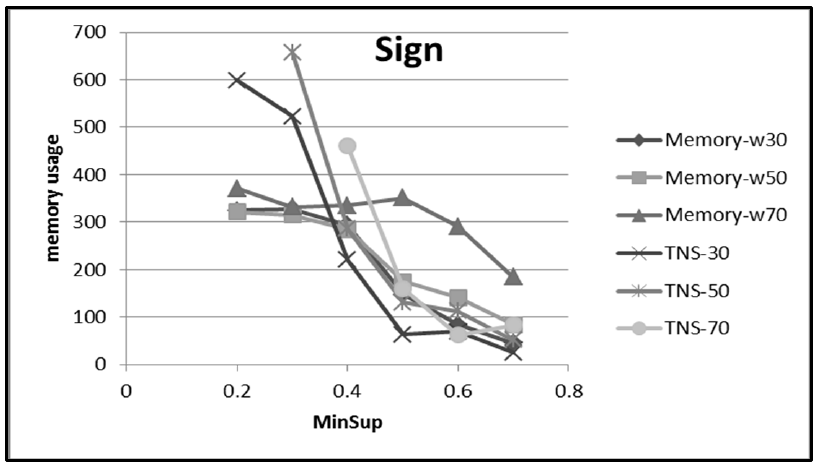
Figure 18. Comparison of memory usage for the TNS with the TRuleGrowth algorithm for (Sign) dataset.